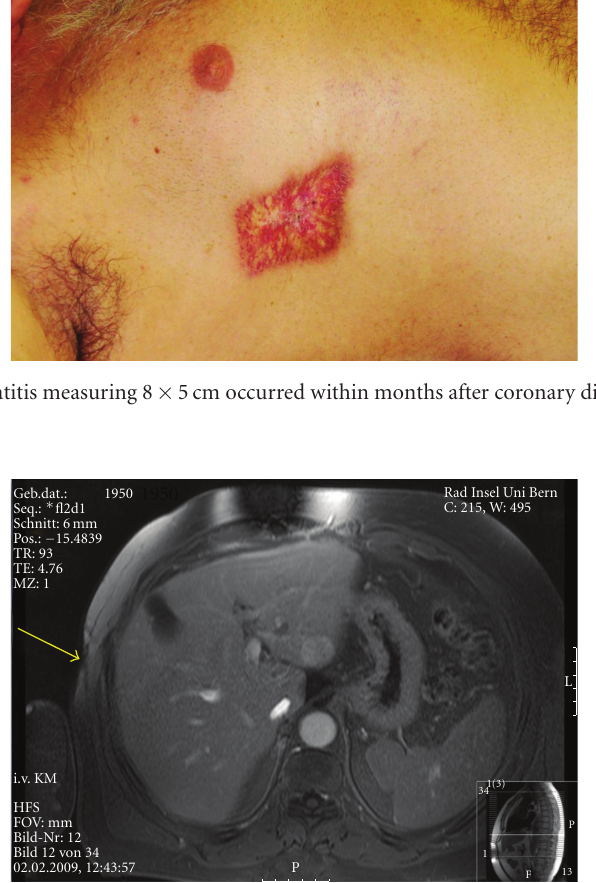
Figure 2: Magnetic resonance imaging (MRI) showing changes in the subcutaneous tissue extending to the